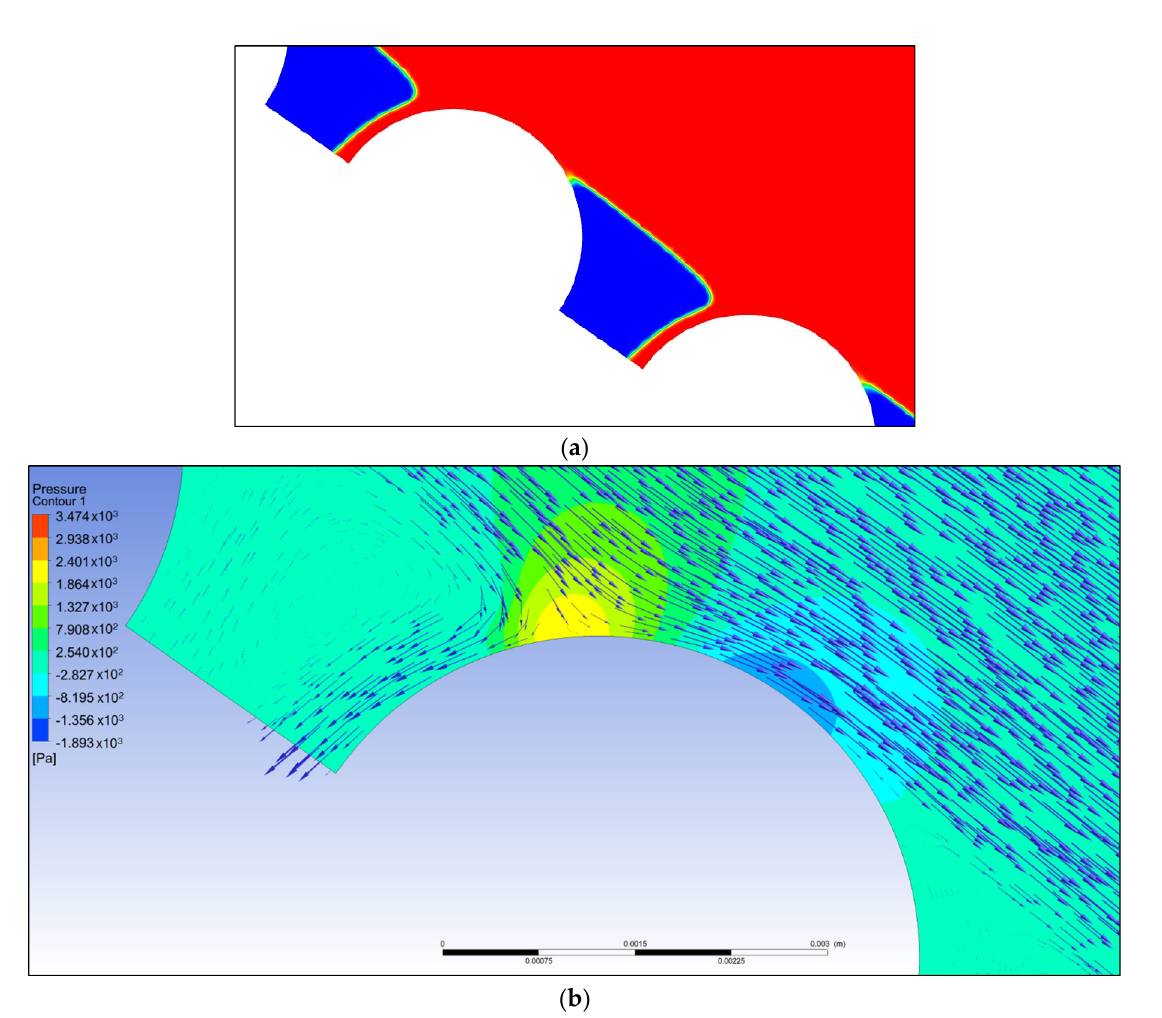
Figure 13. CFD simulation results of circular wire screen; ( a ) two-phase contour volume fraction; ( b ) vectors velocity and pressure contours.